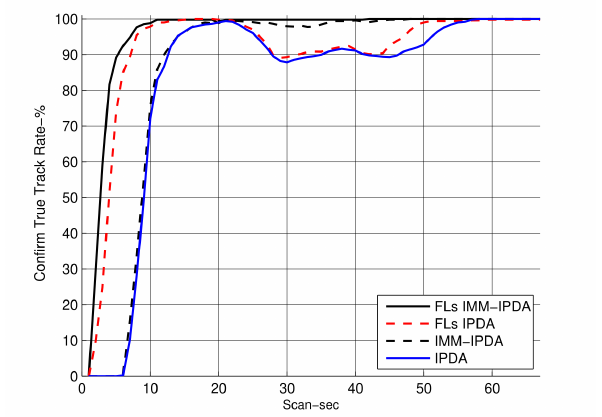
Figure 5. Root mean square error (the smoothing lag is 4).